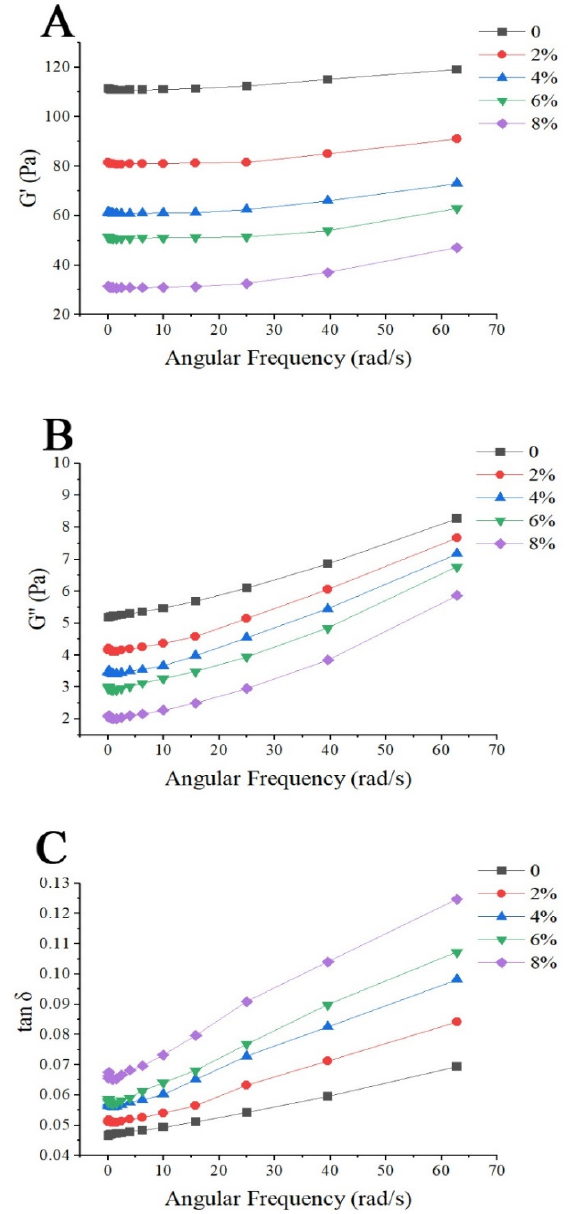
Figure 1. Dynamic rheology of NCS/MBPI gels: ( A ) storage modulus, ( B ) loss modulus, and ( C ) loss factor.